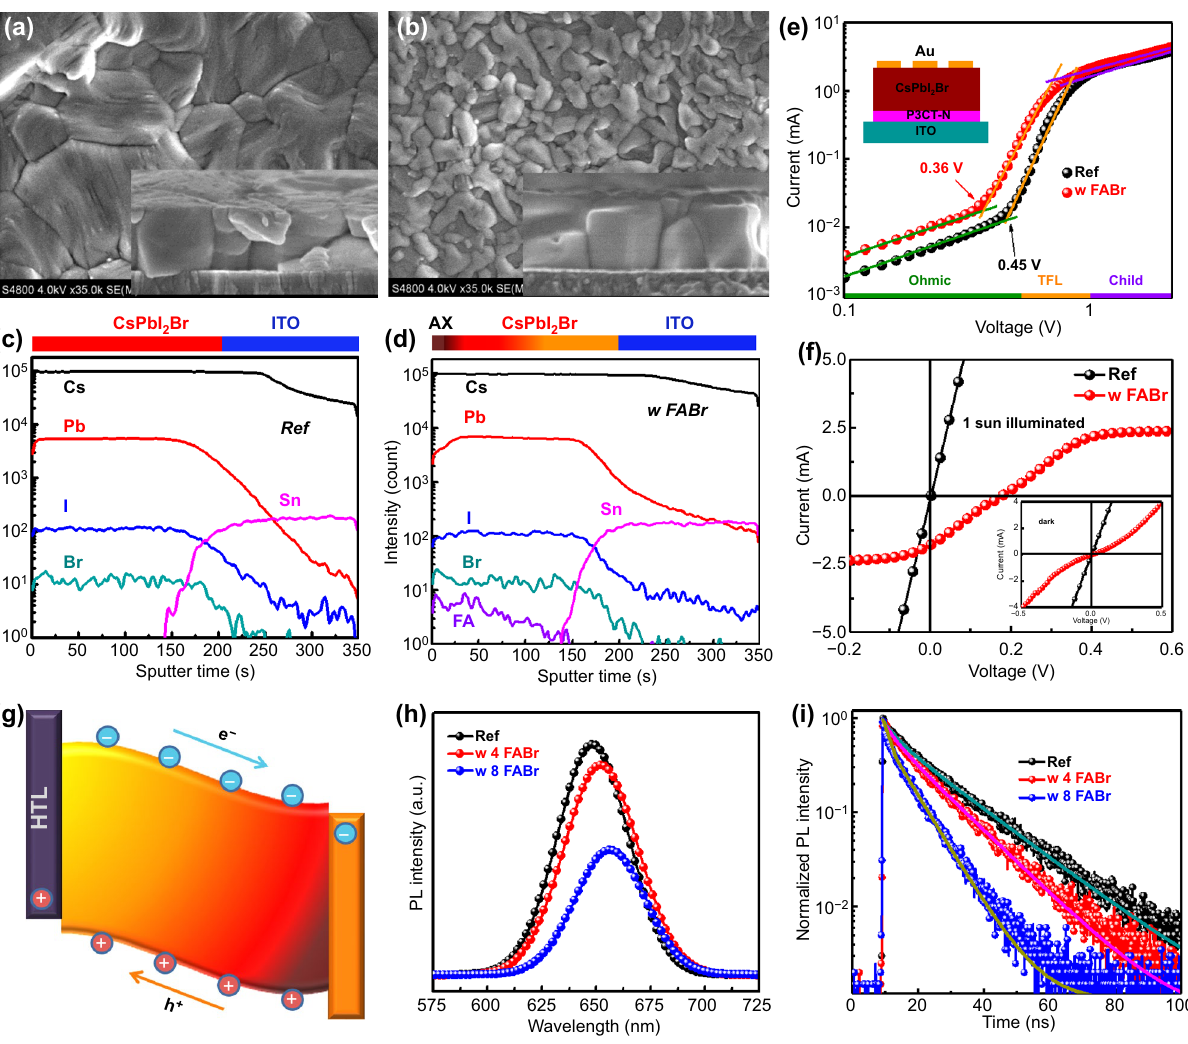
Fig. 2 Top view and cross-sectional (inset) SEM images of a Ref and b 8F CsPbI 2 Br. The TOF–SIMS profiles of c Ref and d 8F CsPbI 2 Br. e Dark I–V plot of the hole-only perovskite device. f I - V curves of the devices with structure of ITO/Au/perovskite/Au measured under dark and 1 sun illuminated. g Schematic illustration of the induced gradient band structure promotes the photo-generated carrier transport. h PL and i TRPL spectra of the Ref film, 4F and 8F